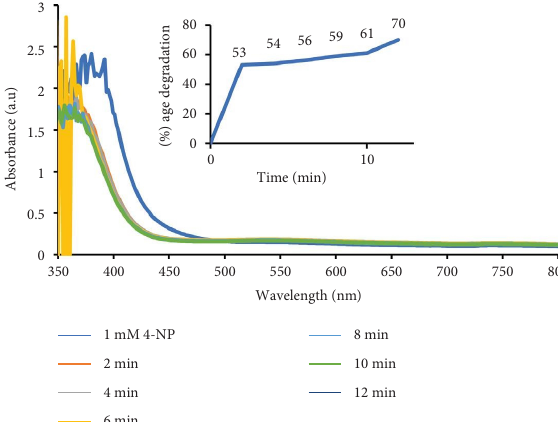
Figure 6: Photocatalytic degradation of 4-nitrophenol using cellulose/MoS